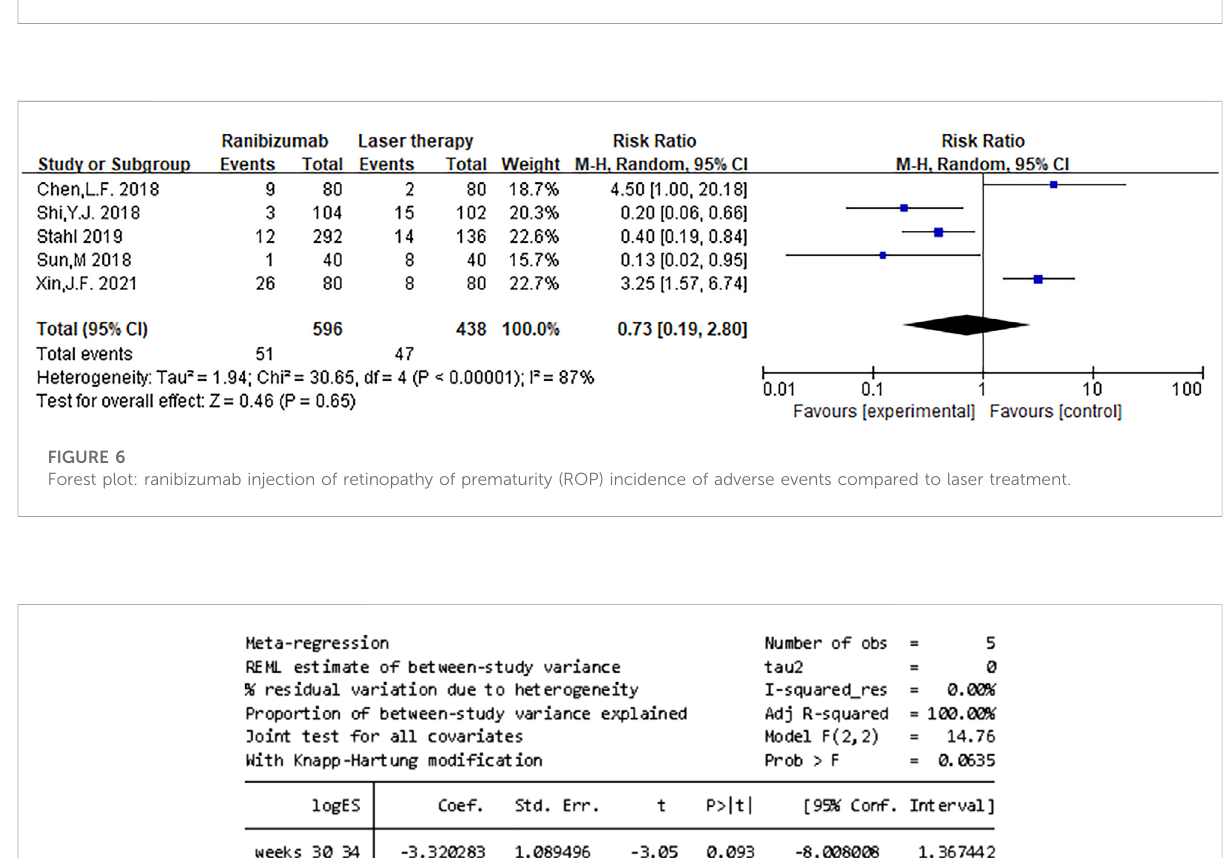
FIGURE 5 Investigation of the heterogeneity in the incidence of adverse events in retinopathy of prematurity (ROP) treated with ranibizumab and laser therapy: (A) Labbe Plot (B) Galbraith Radial Plot.